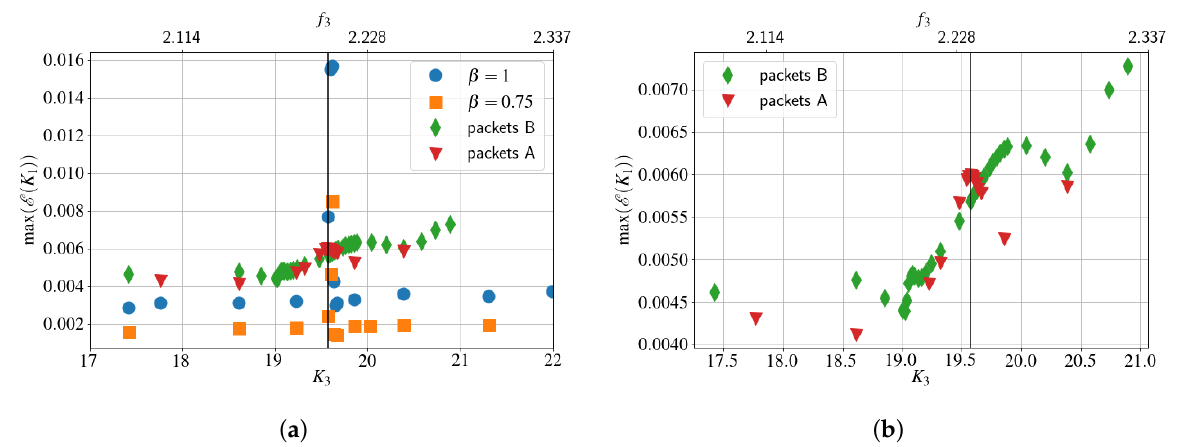
Figure 2. The maximum efficiency max E K as a function of starting K 3 (or f 3 ) for the numerical experiments considered. 1 This demonstrates how narrow the peak transfer is at resonance in the discrete numerical case. ( a ) We show β = 1 (blue circles), β = 0.75 (orange squares), and the encountering wave packets (‘A’ red triangle, defined in Equation (24), and ‘B’ (cid:112) gK 3 /2 π and green diamonds, defined in Equations (25)–(28)). Note the upper axis shows the equivalent frequency f 3 = the ( b ) plot shows the encountering wave packet case in isolation to better visualise the change in behaviour at resonance.